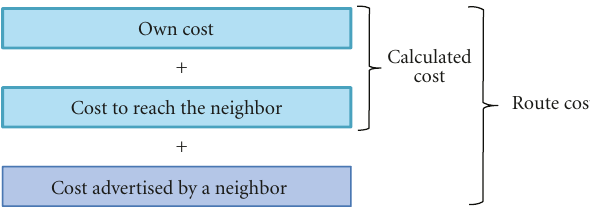
Figure 6: The route cost consists of a cost advertised by a neighbor, a cost to reach the neighbor, and local cost increase caused by the calculating